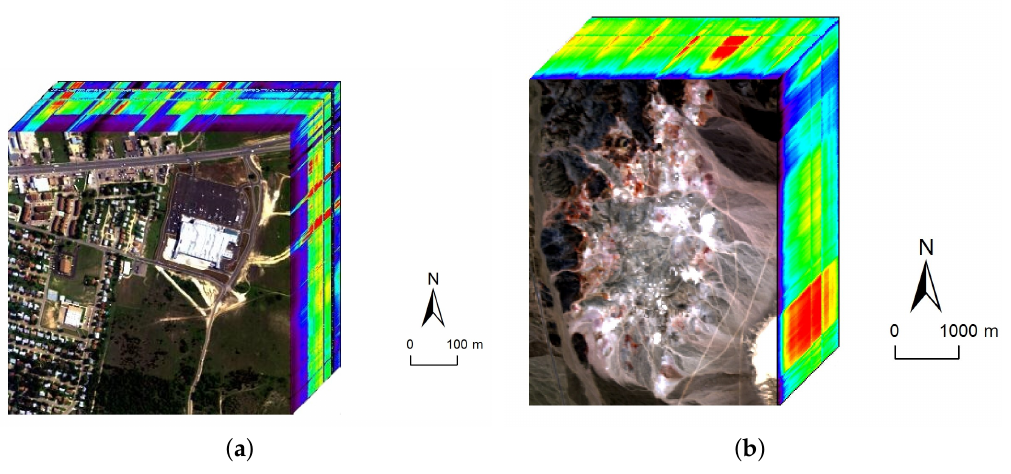
Figure 11. The two real hyperspectral data used in the experiments. ( a ) The Hyperspectral Digital Imagery Collection Experiment (HYDICE) urban dataset; ( b ) The airborne visible/infrared imaging spectrometer (AVIRIS) Cuprite